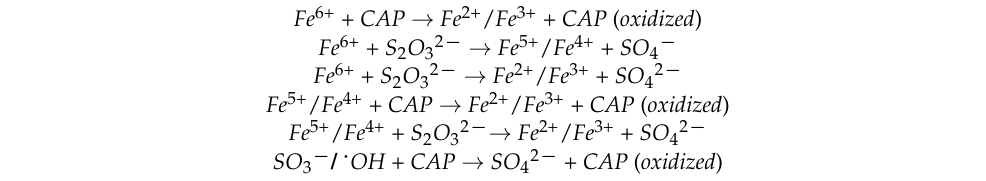
Table 5. Reaction processes involved in forming thiosulfate radicals in Fe(VI)/sulphite system